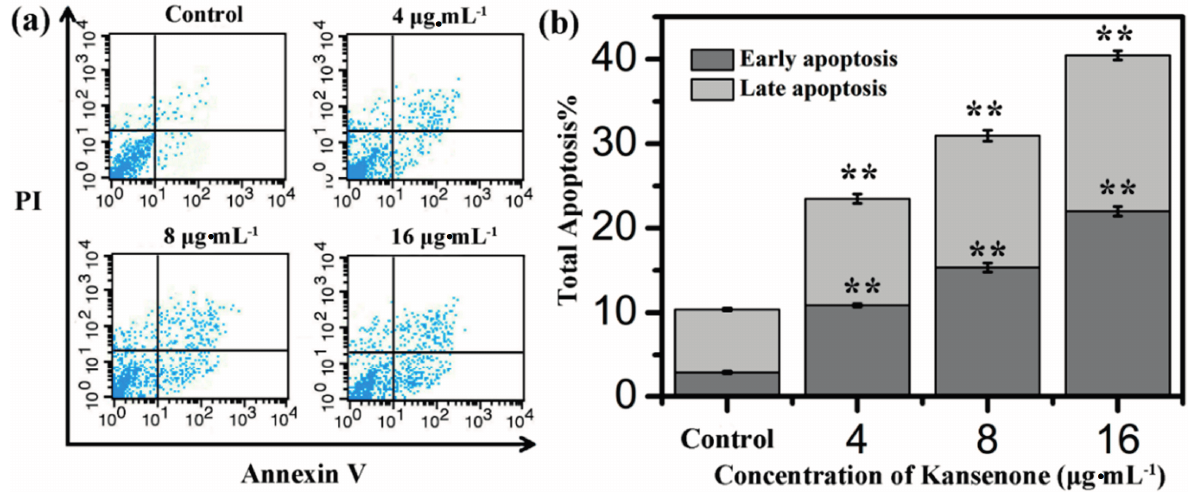
Figure 5. ( a ) Flow cytometry analysis on cell apoptosis of IEC-6 treated with kansenone of different concentration for 48 h; ( b ) Quantitative analysis of the number of apoptotic cells. Compared with corresponding control group, ** p <